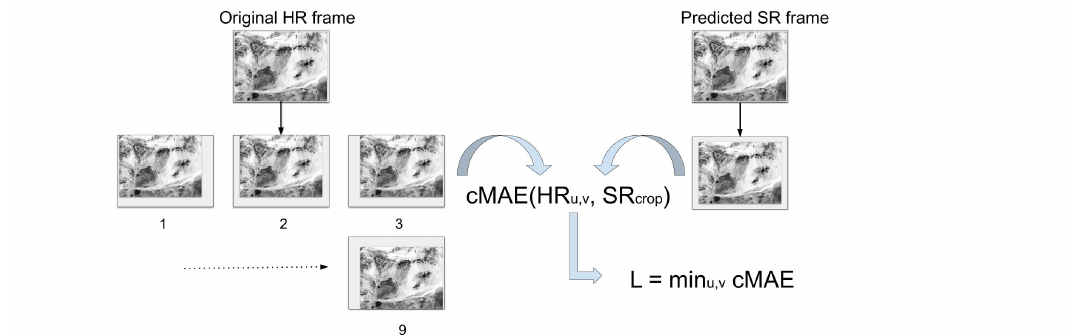
Figure 4. cMAE. For each possible pixel shift u,v, the cMAE is calculated between the cropped SR and the HR u , v patch. In this example figure, the maximum possible shift is 1 (both horizontally and vertically), so 9 patches are extracted for each possible combination. The PROBA-V dataset has a maximum of 3 pixel shifts, so 49 combinations are needed to calculate the final loss. .